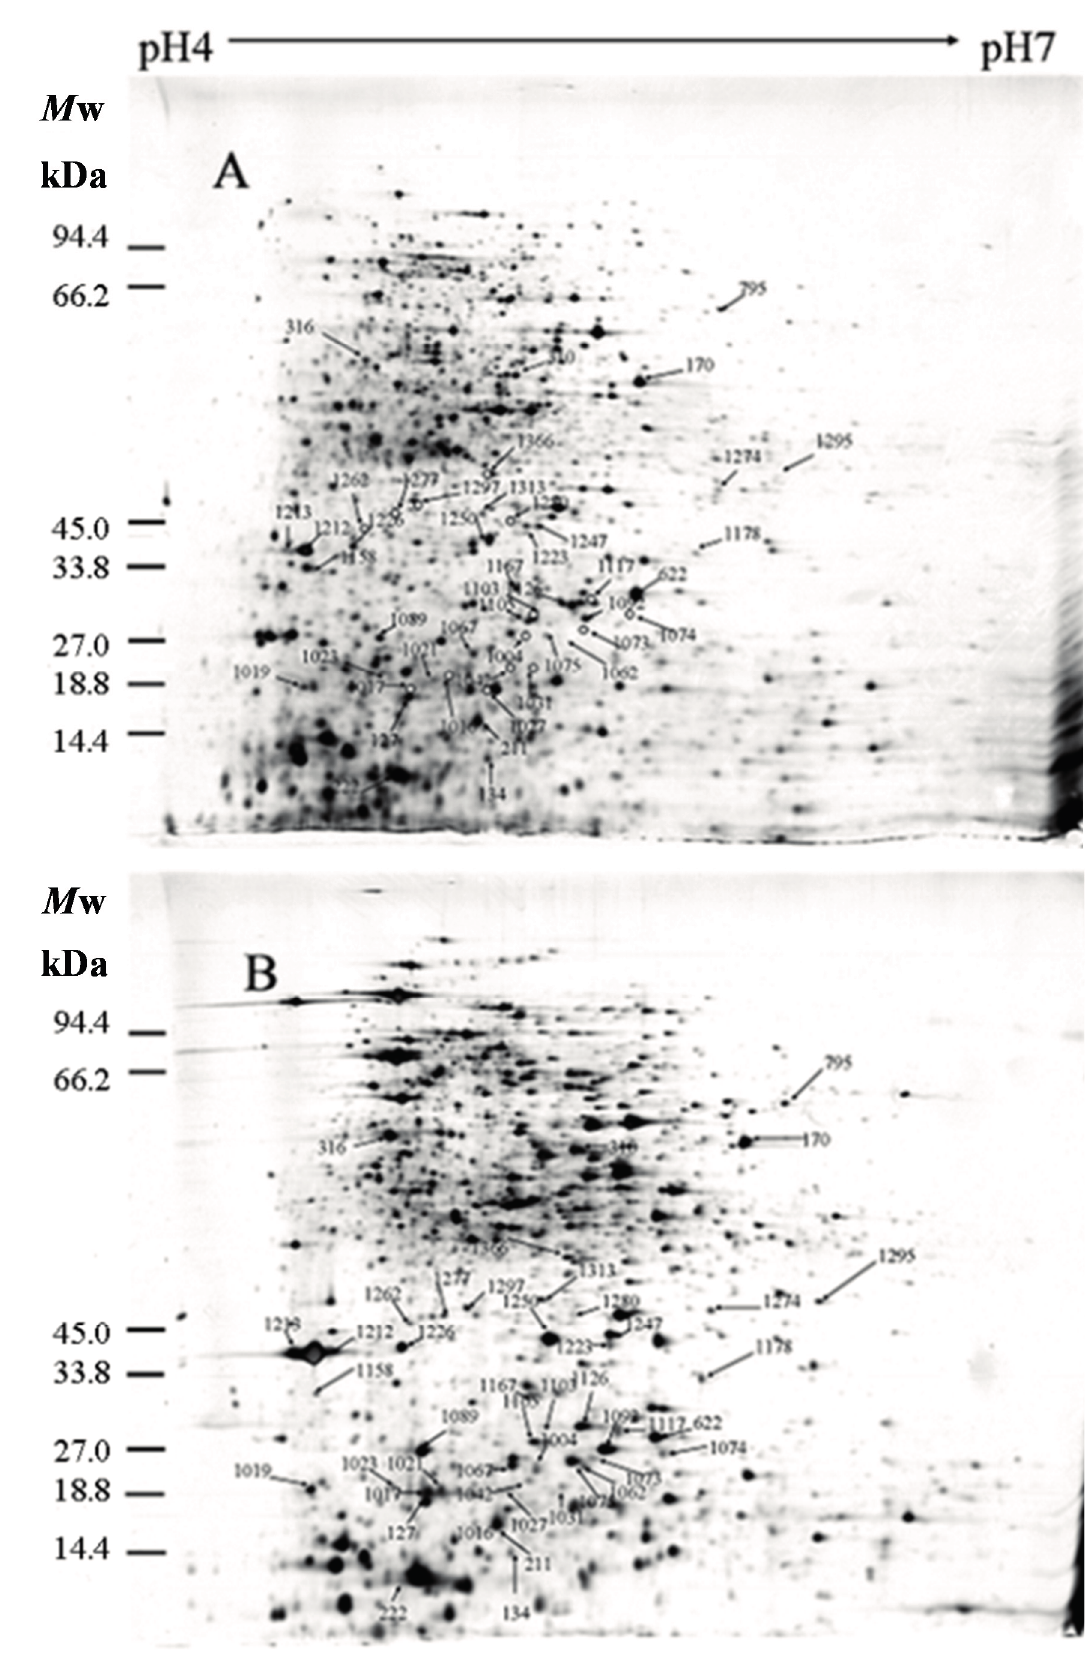
Figure 1. 2-DE maps of the differentially regulated cellular proteins (>2-fold change in expression) of Bacillus amyloliquefaciens FMB38. ( A ) ES-2-4; and ( B )